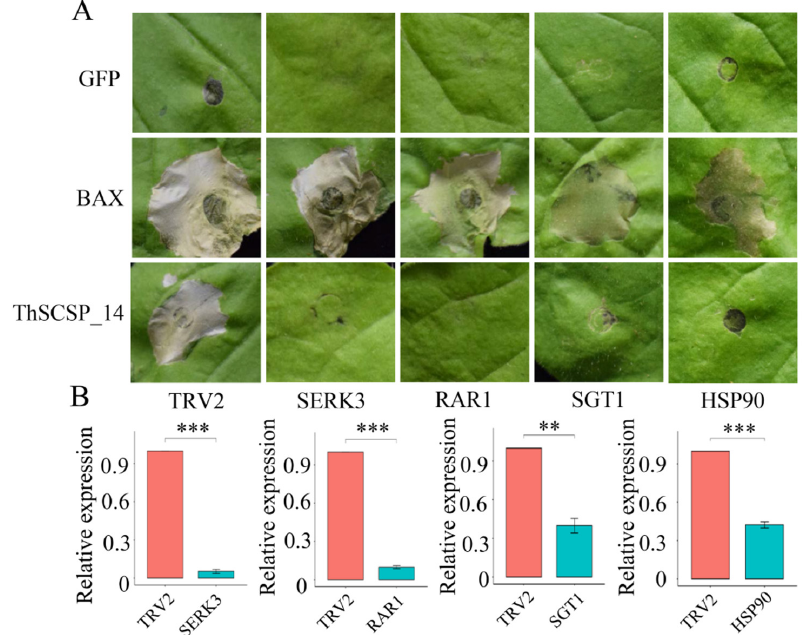
Figure 5. The RAR1, SGT1, HSP90, and SERK3 are necessary for the necrosis phenotype triggered by ThSCSP_14. ( A ) Representative photographs of the ThSCSP_14-triggered necrosis phenotype in silenced Nicotiana benthamiana leaves at 4 days post-infiltration (dpi). Agrobacterium tumefaciens carrying ThSCSP_14 was infiltrated into the upper leaves of silenced plants at 21 dpi using tobacco rattle virus (TRV) constructs. The control was un-silenced plants. ( B ) The transcript expression levels of RAR1, SGT1, HSP90, and SERK3 in the corresponding silenced plants analyzed by qRT-PCR. The constitutively expressed gene NbActin served as internal reference. Error bars are the standard deviation SD of three biological replicates (** p < 0.01; *** p < 0.001).